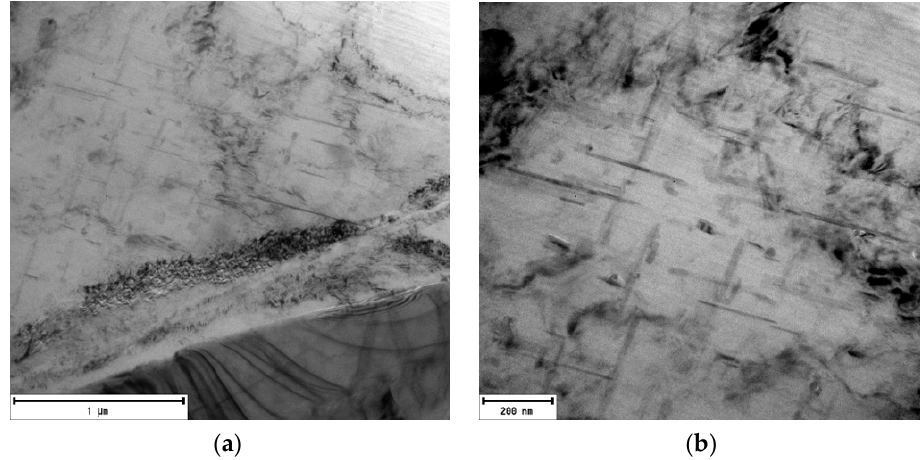
Figure 11. Substructure of 20–80 alloy after artificial aging, TEM; ( a ) Overview ( b ) Detailed view. Materials 2020 , 13 , x FOR PEER REVIEW